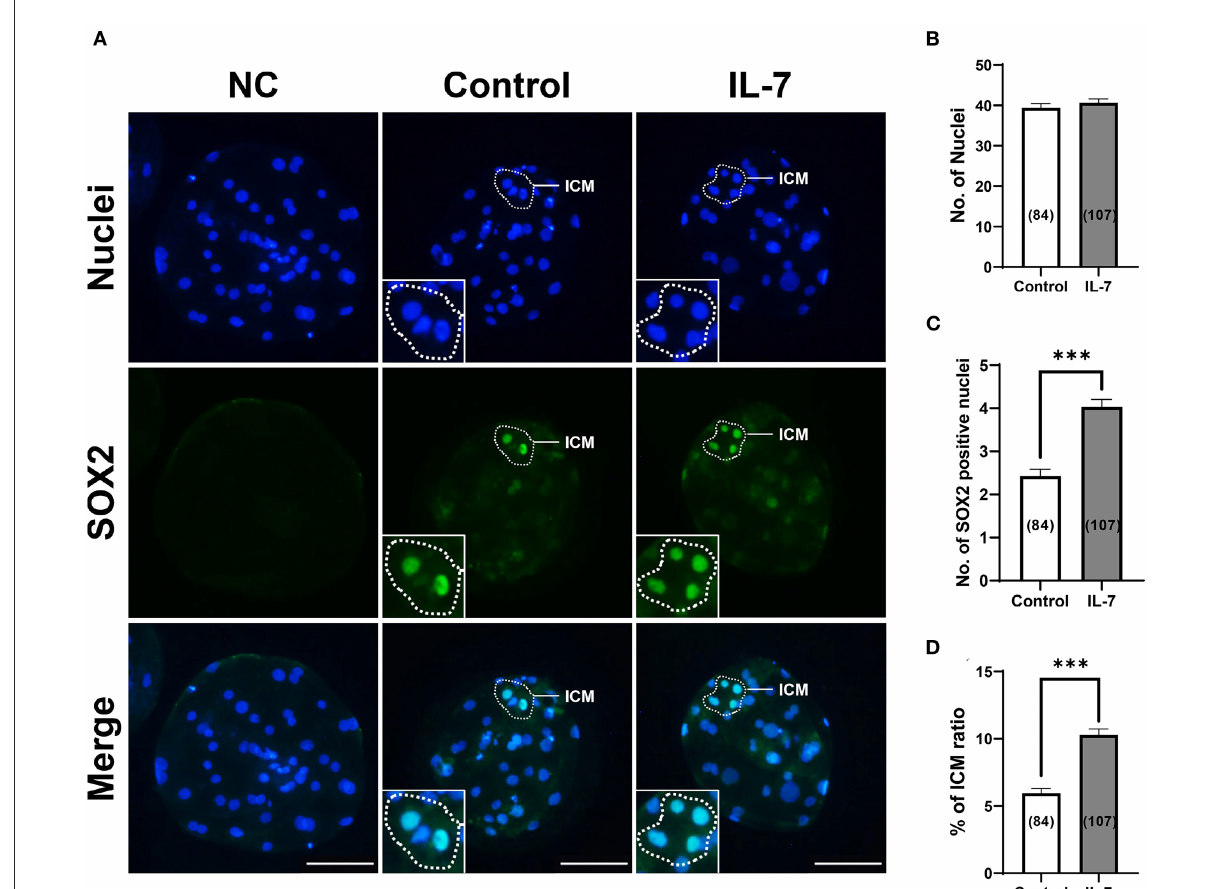
FIGURE8 Effects of IL-7 supplementation during IVC on inner cell mass (ICM) specification of blastocysts after PA. (A) Representative immunofluorescence images (200 × ) of porcine parthenote blastocysts labeled with Hoechst 33342 (Total nuclei, blue) and SOX2 (ICM marker, green) after IVC. NC, negative control. Scale bar: 100 µ m. (B–D) Quantification of the total, SOX2 positive cell numbers, and ICM ratio in the indicated groups. The number of embryos examined in each experimental group is shown in parentheses. Asterisks indicate